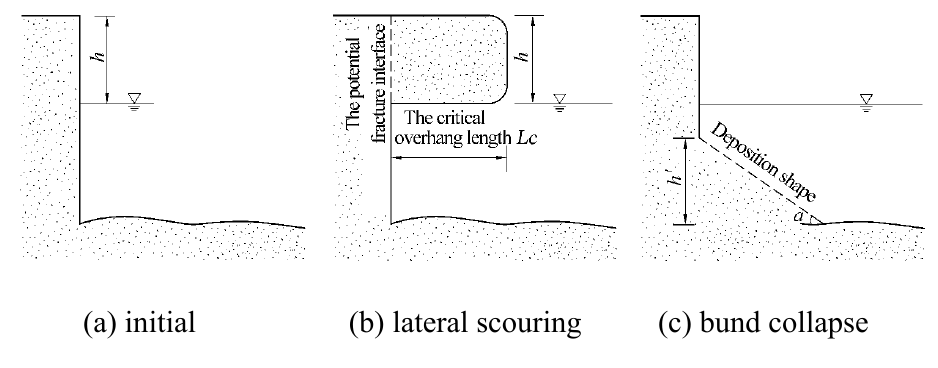
Fig. 2 Lateral widening mode of the break. Fig. 2. Lateral widening mode of the